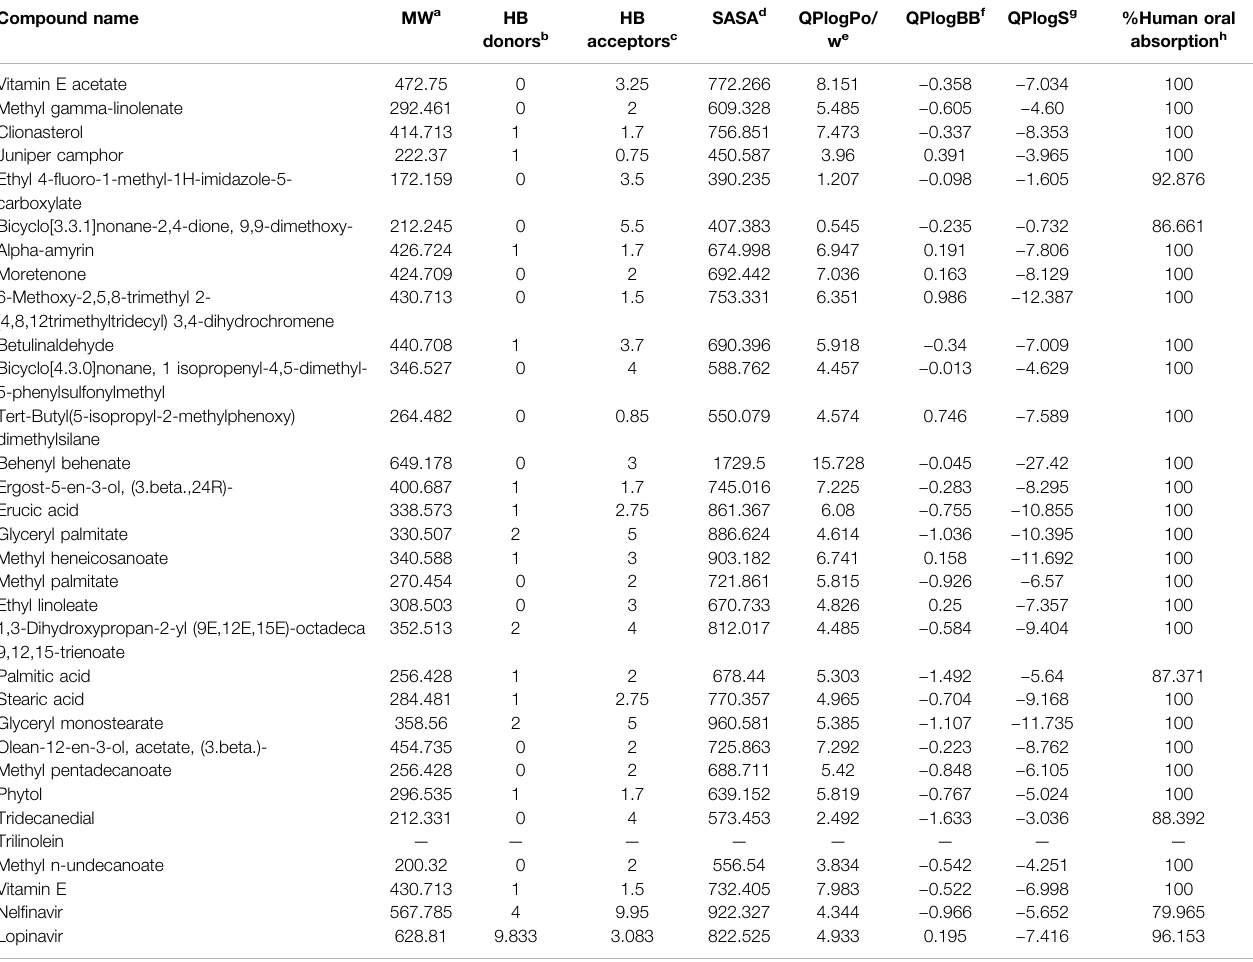
TABLE 5 | ADME and drug likeness properties of selected bioactive isolated compounds from methanol extract of C. gigantea . Compound name